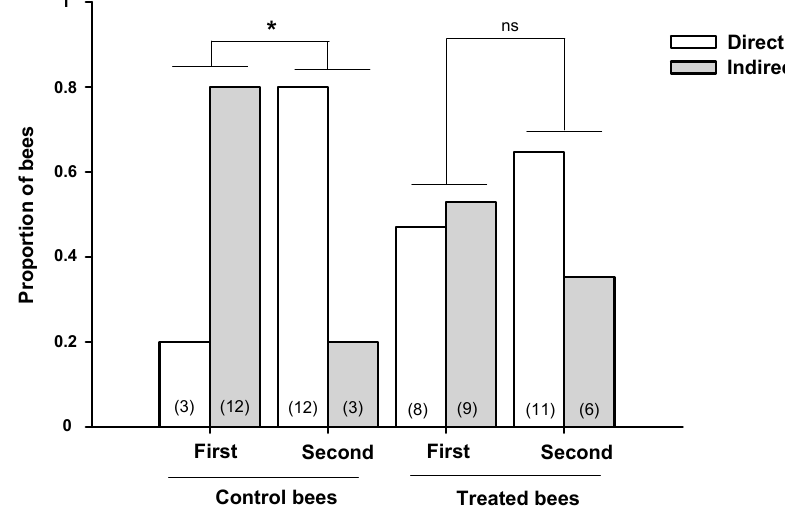
Figure 4. Effect of an acute exposure to GLY on forager transitions from direct to indirect homeward flights after two releases. Proportion of bees performing direct and indirect flights after the first and the second release after feeding sucrose solution with or without GLY (0 mg L − 1 for control and 2.5 to 10 mg L − 1 for treated bees). White bars: direct flights; grey bars: indirect flights. * p < 0.05 (Fisher’s exact test). ns: no significant differences ( p > 0.05, (Fisher’s exact test). Numbers in brackets indicate